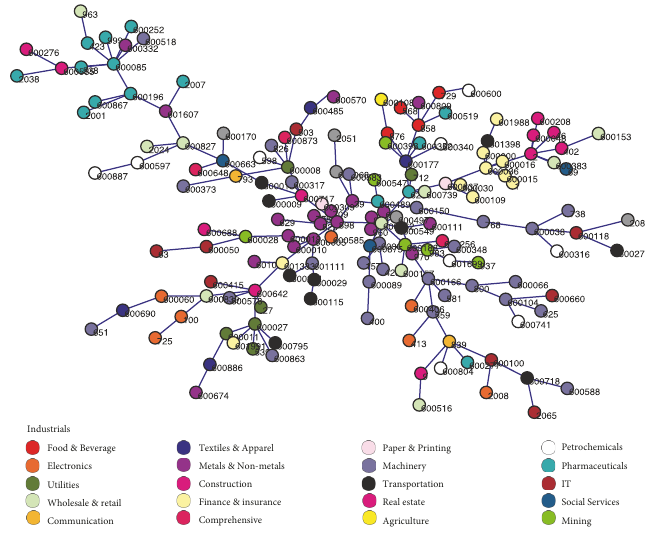
Figure 13: Minimum spanning tree of CSI163. Vertices are colored to indicate different industry sectors.